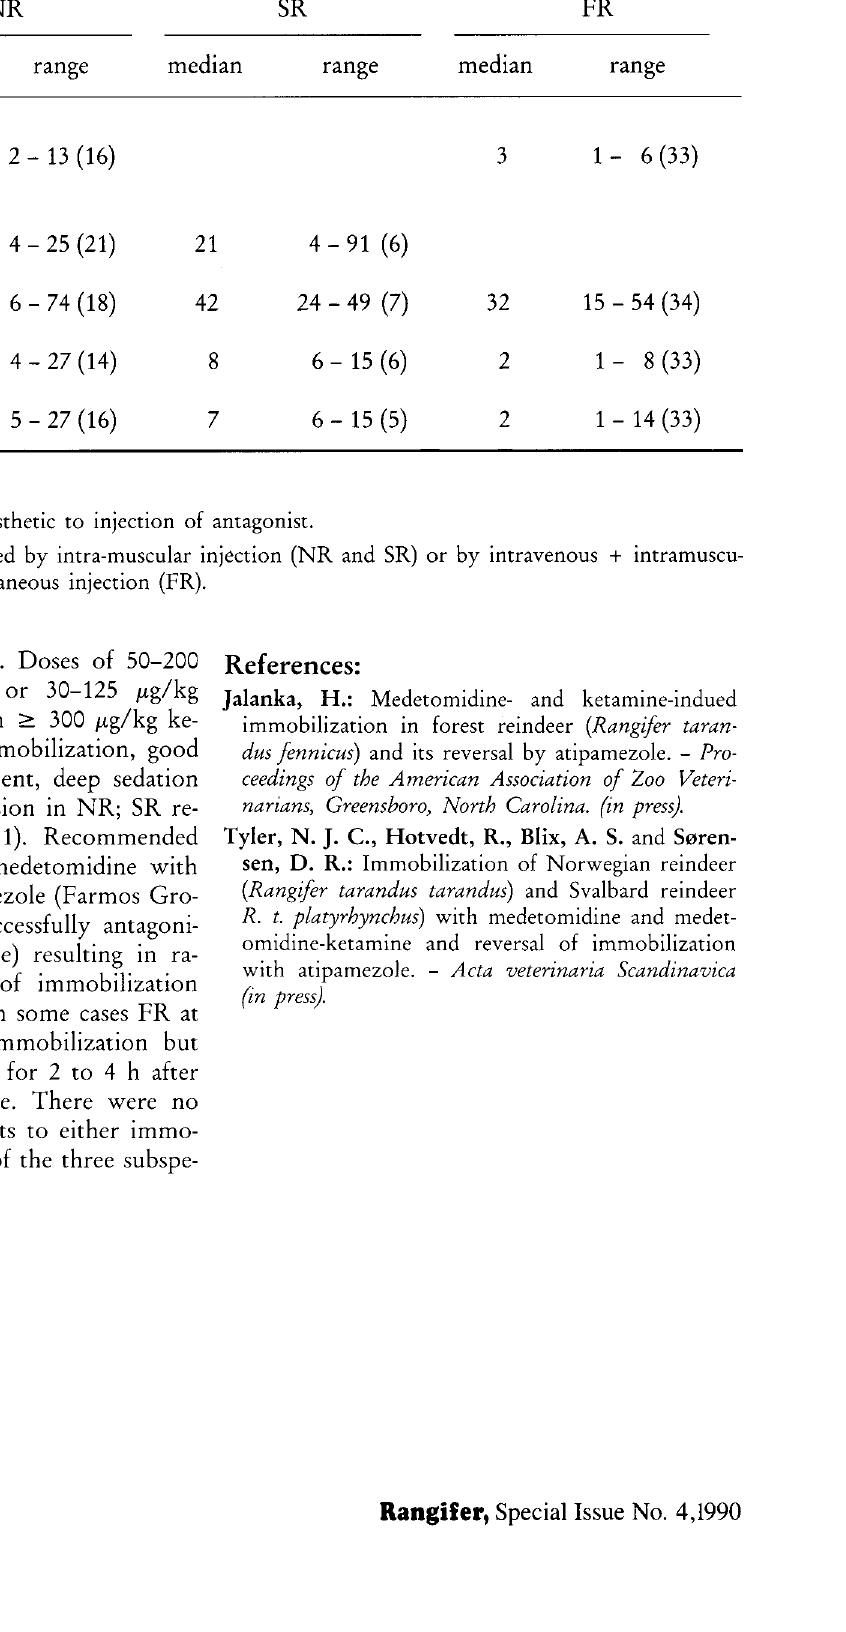
Table 2. Response times (min.) of Norwegian reindeer aged > 2 yrs (NR), Svalbard reindeer (SR) and wild forest reindeer (FR) to medetomidine, medetomidine-ketamine and atipamezole (number of trials).